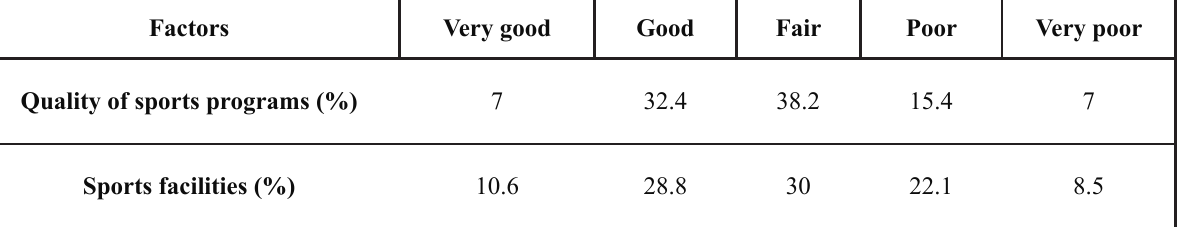
Table 1. Percentage of satisfaction of students with the quality of sports facilities and programs of their